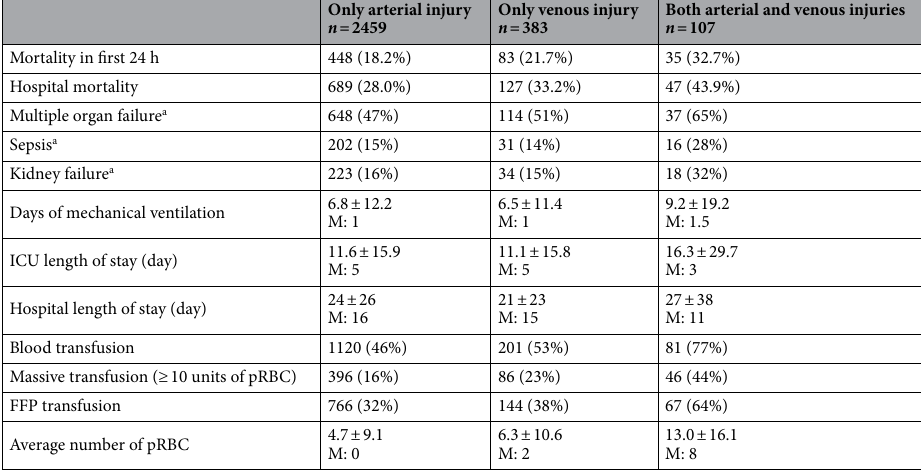
Table 4. Impact of venous injury on patient outcomes after abdominal trauma. Continuous variables presented with mean, SD, and median. pRBC packed red blood cells, FFP fresh frozen plasma, M median. a Available only in patients with standard documentation (68% of all